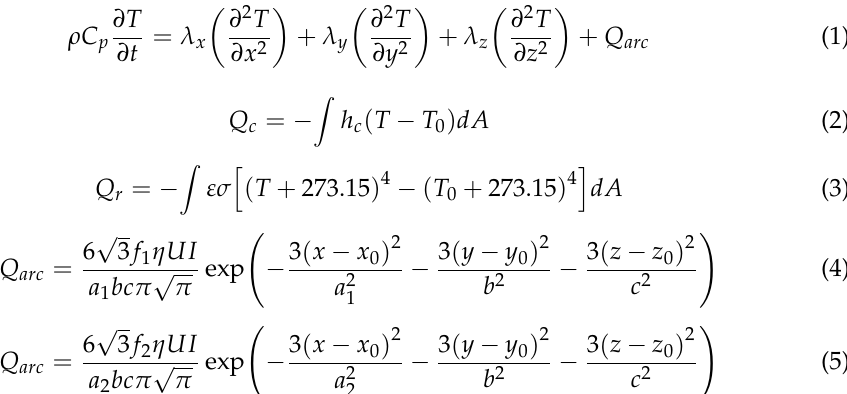
Table 7. Goodness of fit.